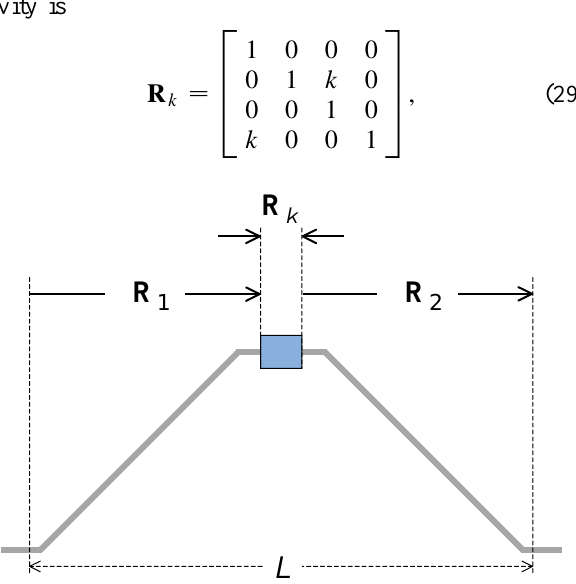
FIG. 2. (Color) Schematic diagram of the chicane and transverse cavity at its